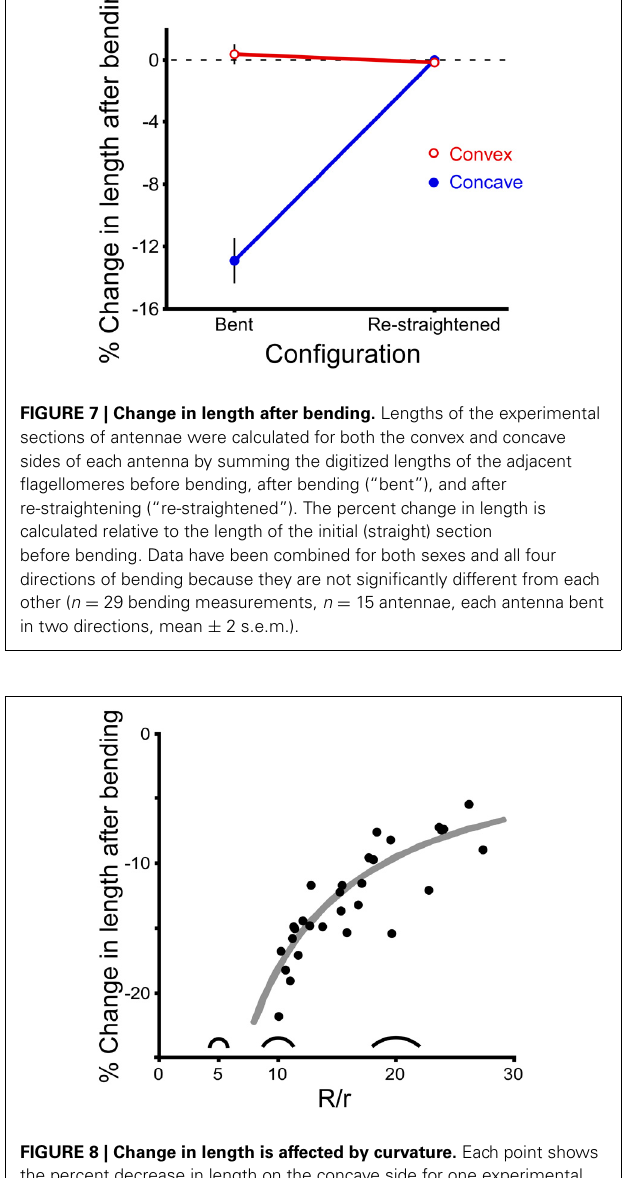
FIGURE 8 | Change in length is affected by curvature. Each point shows the percent decrease in length on the concave side for one experimental section of an antenna caused by bending one antenna in one direction ( n = 29). The amount of bending is reported as dimensionless curvature ( R / r where R is the radius of curvature and r is the average radius of the bent section of the antenna), with three silhouettes illustrated as examples ( R / r = 5, 10, and 20). The gray line represents the theoretical change in length on the concave side of a cylinder that is bent assuming that both the length of the convex side and the diameter remain unchanged during